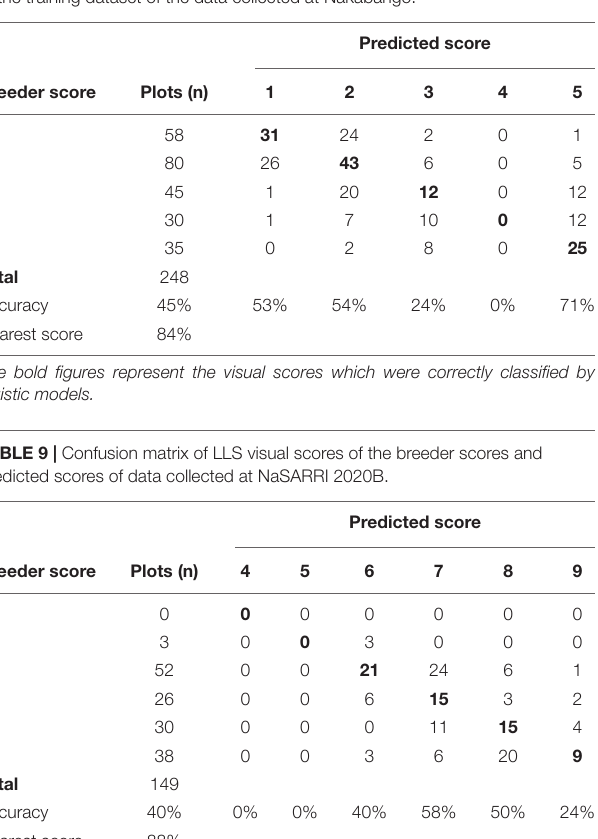
TABLE 8 | Confusion matrix of GRD visual scores and the model predicted scores of the training dataset of the data collected at Nakabango.